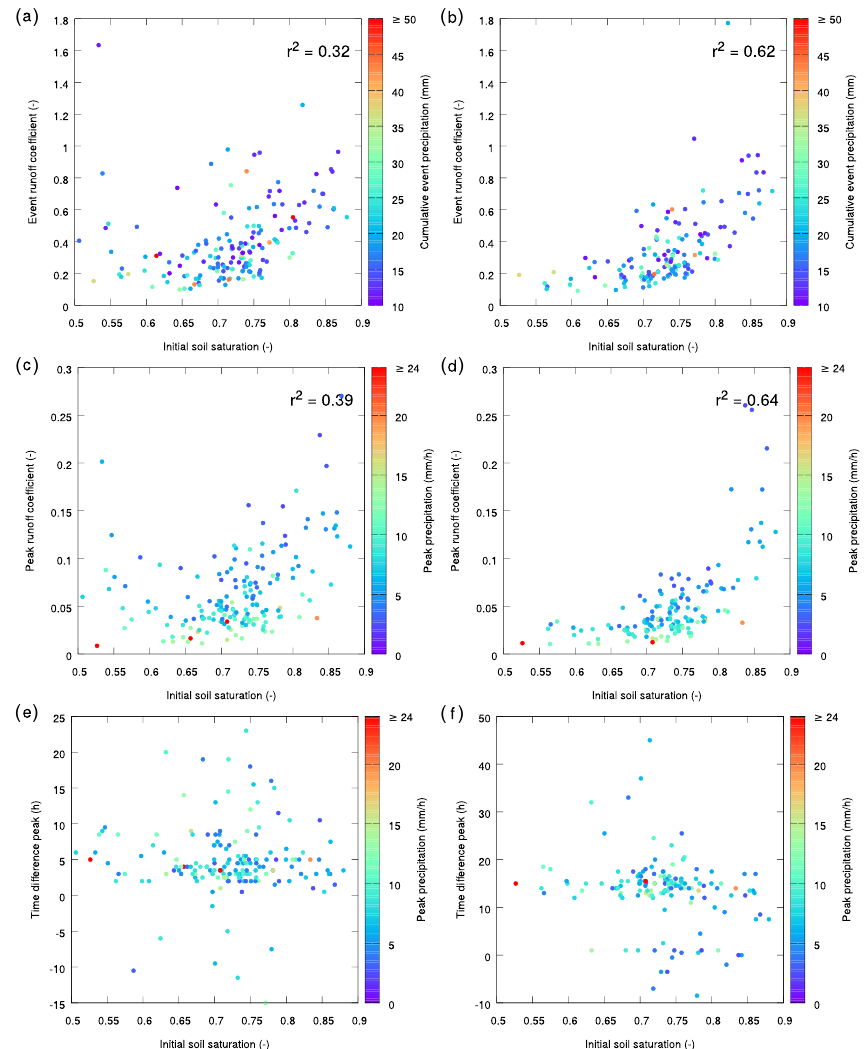
Figure 11. Rainfall event runoff coefficients for measured discharge as a function of initial soil saturation in the upper 40cm of the soil (a) and similar results for simulated discharge (b) . Peak rainfall runoff coefficients for measured discharge as a function of soil saturation (c) and similar results for simulated discharge (d) . Time difference between peak rainfall and measured peak discharge (e) and similar results for simulated peak discharge. Points are coloured according to the event rainfall sum (a, b) or the peak rainfall (c, d, e, f)